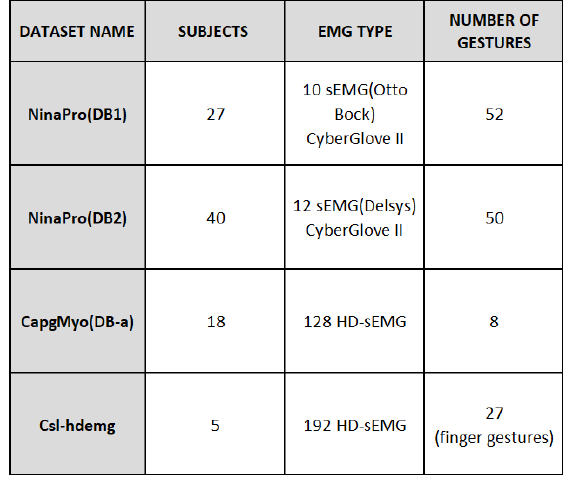
Figure 1. Public database summary